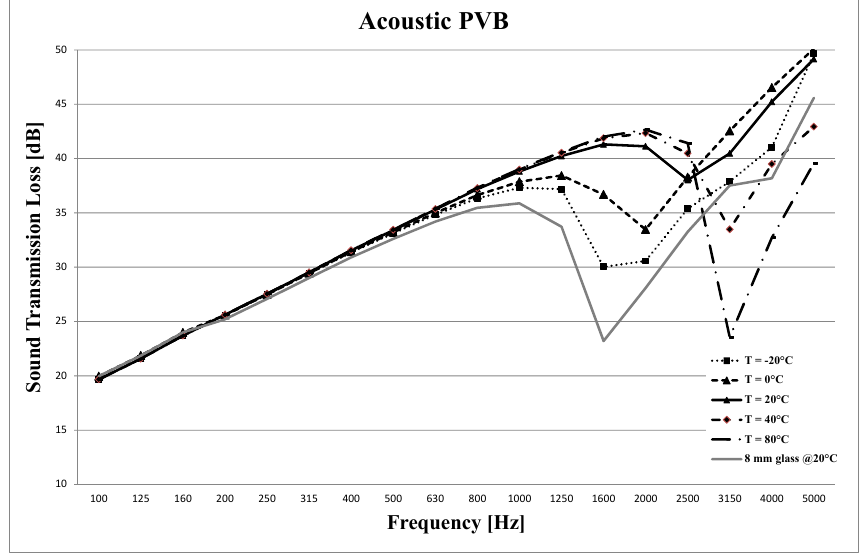
Fig. 14 Sound Transmission Loss Curves of glasses laminated with acoustic PVB at different temperatures